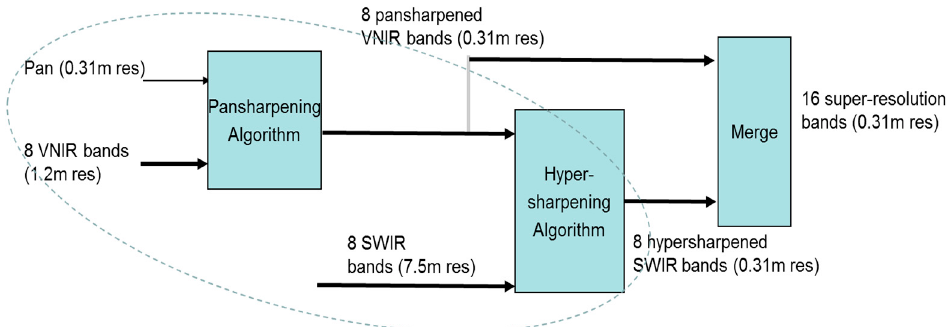
Figure 12. Approach 2: Sequential Fusion.